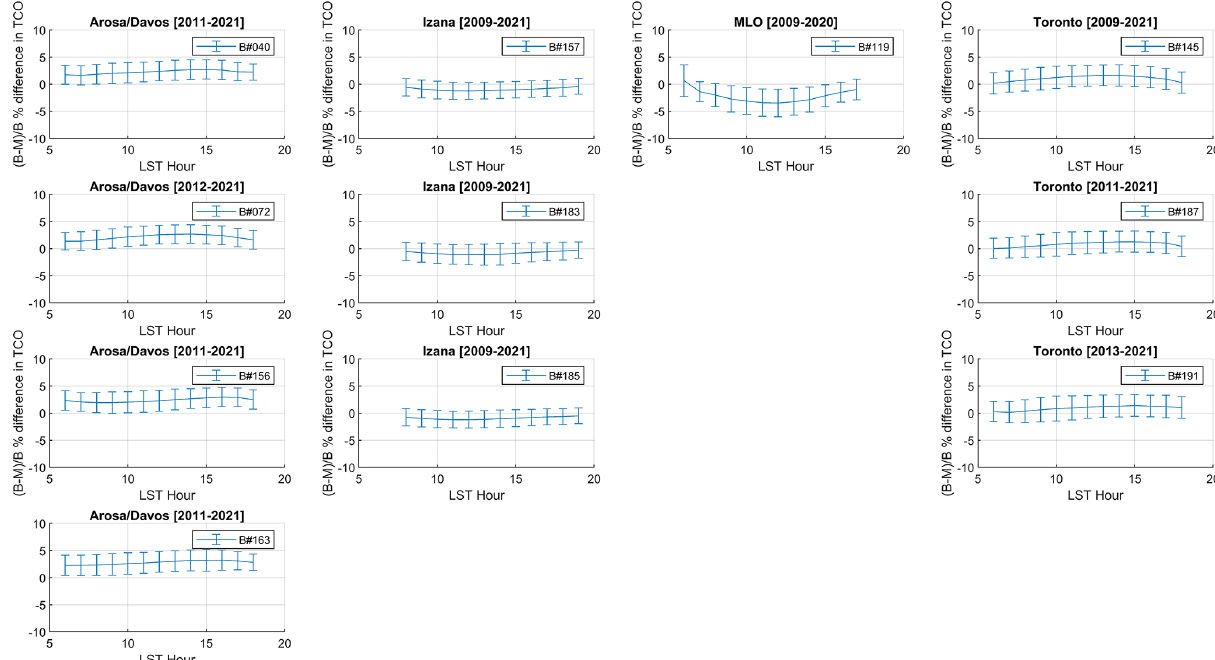
Figure A3. Brewer and MERRA-2 TCO percent difference binned by the hour of local standard time. The percentage difference is calculated as ( Brewer − MERRA-2 )/ Brewer. Error bars are the 1 σ of the hourly-binned percentage difference. The site and data period are shown in the title of each panel. The Brewer instrument numbers are given in the legend.